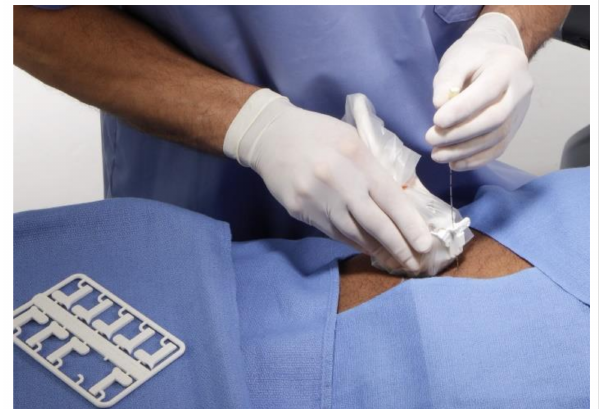
Figure 11. CIVCO needle guidance system improves beam needle alignment. Photo credit: CIVCO Medical Solutions.